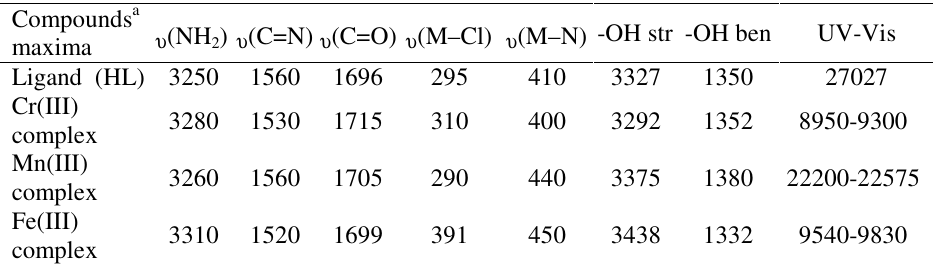
Table 2. IR spectral bands position/cm ¯1 and electronic spectral data (in DMSO) cm ¯1 of the Schiff base ligand and its metal